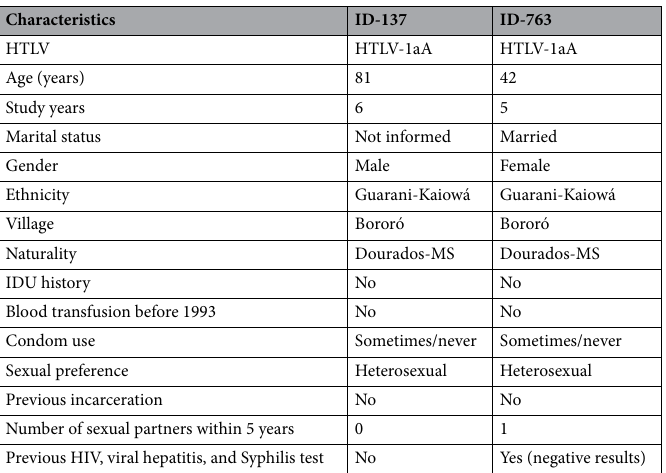
Table 2. Sociodemographic and risk behavior characteristics of the two HTLV-1 infected individuals. ID-identification number of the participant sample, IDU-Injection drug use, MS-Mato Grosso do Sul state.